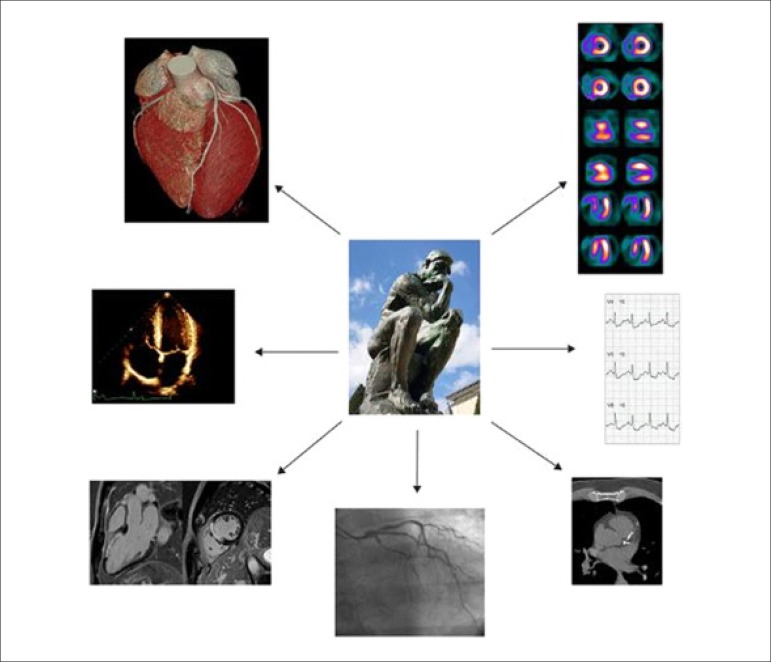
The importance of integrating information about different diagnostic modalities in an era of multimodalities. Generally speaking, the diagnostic modalities most used in Brazil are: exercise testing, echocardiogram, myocardial perfusion scintigraphy, angiotomography to evaluate coronary anatomy and calcium score, cardiac magnetic resonance, and, finally, invasive coronary cineangiography (cardiac catheterization). In this scenario, the doctor is central to establishing the best strategy and should ask the following questions: (1) What is my patient’s clinical profile? (2) What information am I looking for regarding the clinical hypotheses I have raised? (3) What test will provide this information? (4) Will I need further information to make a decision and manage this patient?